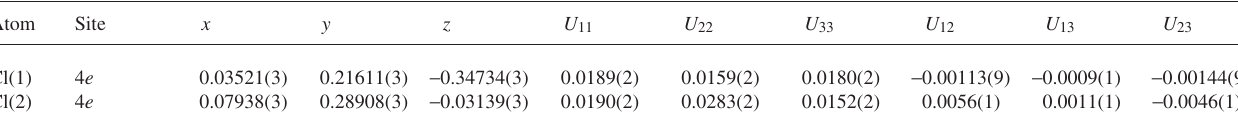
Table 3. Atomic coordinates and displacement parameters (in Å 2 )